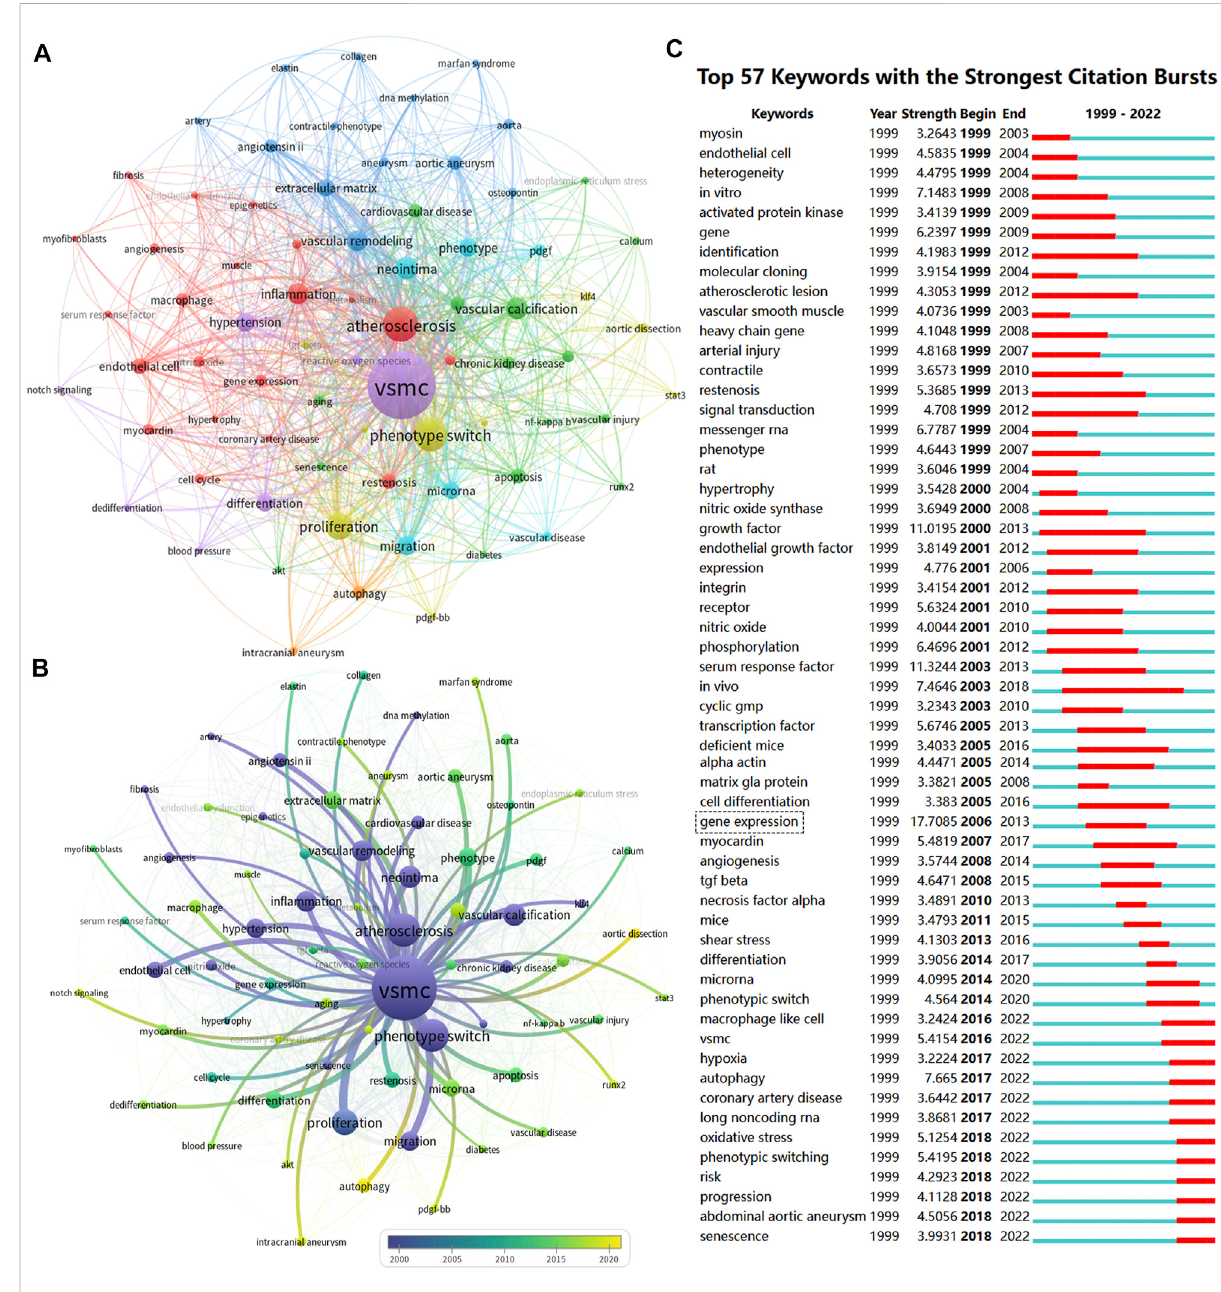
FIGURE 7 Co-occurrence analysis of keywords. (A) The co-occurrence networks of author keywords were visualized by VOSviewer. Large nodes represent keywords with relative higher occurrence; Same color indicates relatively closer relationship; (B) The timeline view of keywords in VOSviewer,blueindicatesoccurredfrequentlyinearlystage(around2000),yellowindicatesoccurredfrequentlyinlatestage(around2020). (C) The top 57 keywords with the strongest citation bursts represent hot topics in different periods. The red bar indicates the burst duration. The burst strength refers to the importance to the research fi